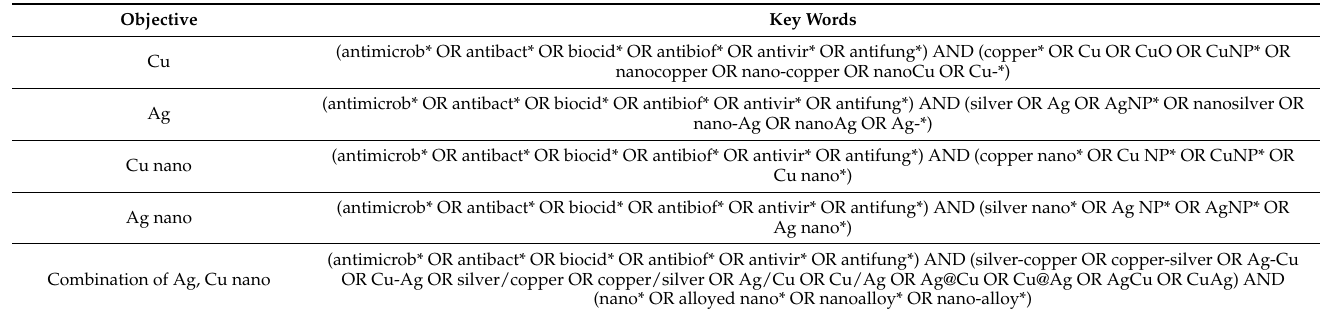
Table A1. Data examined in the Polytechnique Montreal library Compendex